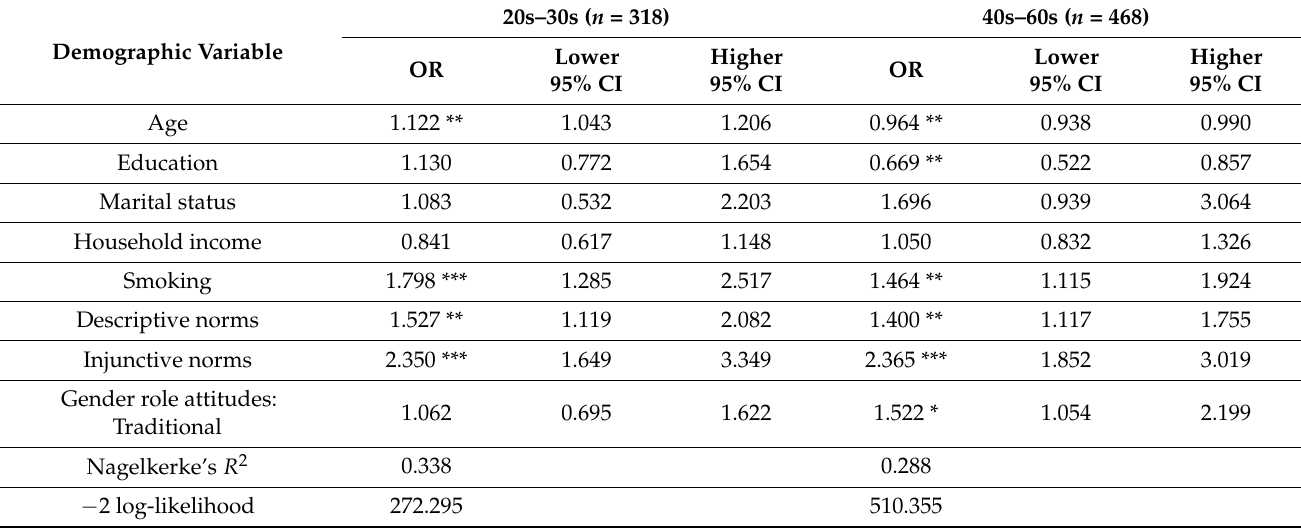
Table 4. Logistic regression analyses predicting high-risk drinking across age